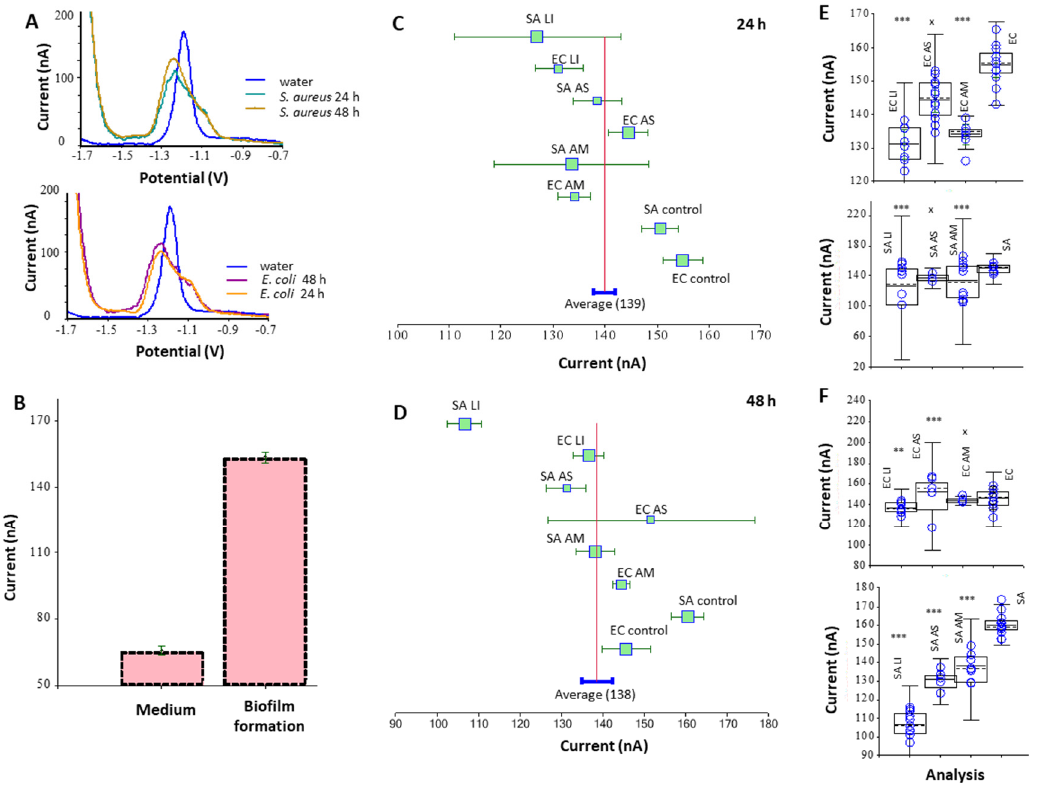
Figure 8. Electrochemical study of biofilm formation—the Brdicka reaction. A range of measurement: − 0.7 V to − 1.95 V; voltage amplitude: − 25 mV; time amplitude: 0.8 s; measurement time: 10 ms; pulse time: 30 ms; voltage step: 4 mV; sweep rate: 5 mV/s; sample volume: 10 µ L; Brdicka buffer volume: 3 mL. Dependence of electrical current (nA) on potential (V). Mutual curve comparison between water and biofilm formation in the first and the second day for E. coli (EC) and S. aureus (SA) ( A ). Comparison between absolute area signals among medium and biofilm ( B ). Forest plot comparing effect of using 20 µ g/mL of AgNPs from L. indica (LI), A. scholaris (AS), and A. multifolium (AM) on biofilms of S. aureus and E. coli against non-treated biofilms in 24 h ( C ) and 48 h ( D ). Box-plots comparing the overall area of non-treated biofilms and biofilms treated with 20 µ g/mL AgNPs from LI, AS, and AM during 24 h ( E ) and 48 h ( F ).